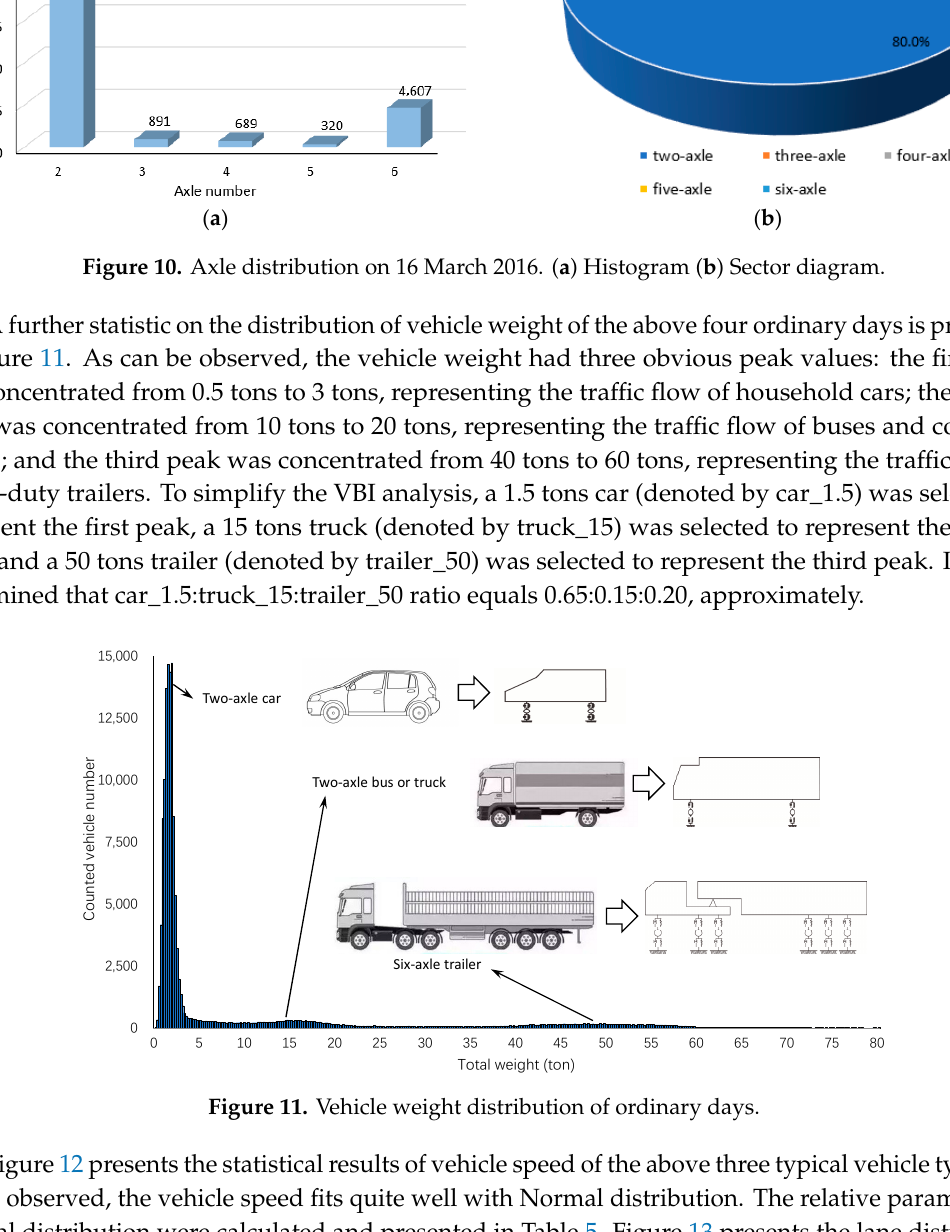
Figure 11. Vehicle weight distribution of ordinary days.